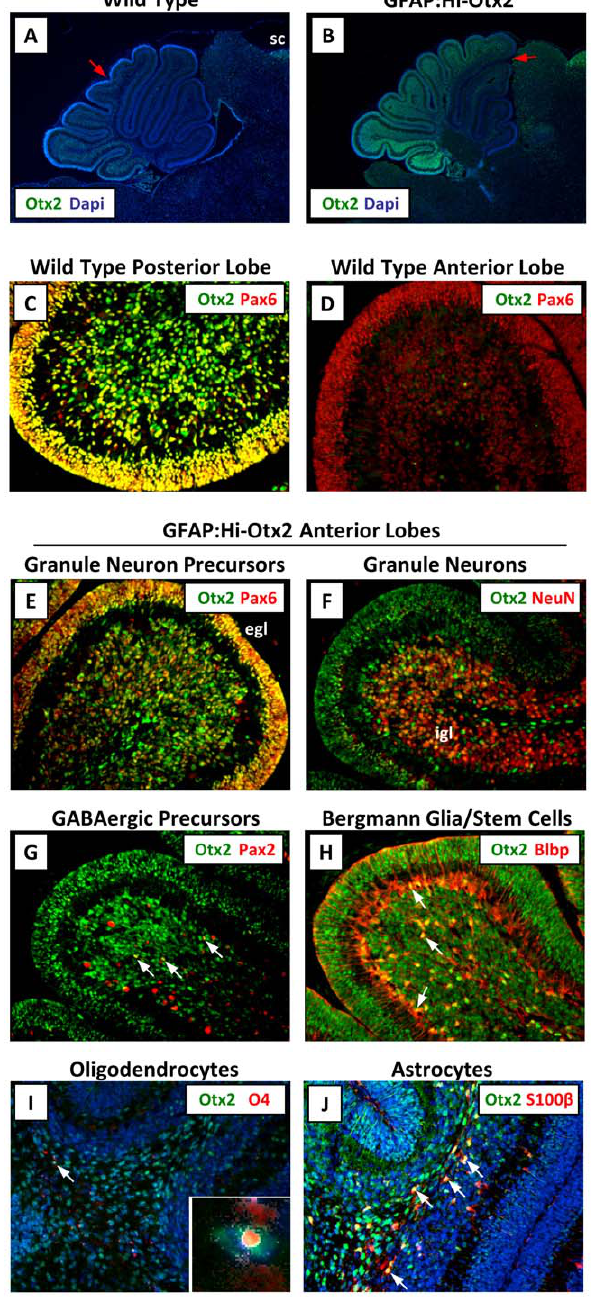
Figure 1. Otx2 expression is induced in various cell types in GFAP:Hi-Otx2 mice. Sections from P7 wild type (A, C–D) or GFAP:Hi- Otx2 (B, E–J) mice were immunostained with the indicated antibodies. For (A) and (B), anterior expression threshold is designated with a red arrow. (A, B) are shown at 4 6 magnification (mag), all others 20 6 mag. sc, superior colliculus; egl, external granule layer; igl, internal granule layer. White arrows indicate overlapping expression of the indicated markers in individual